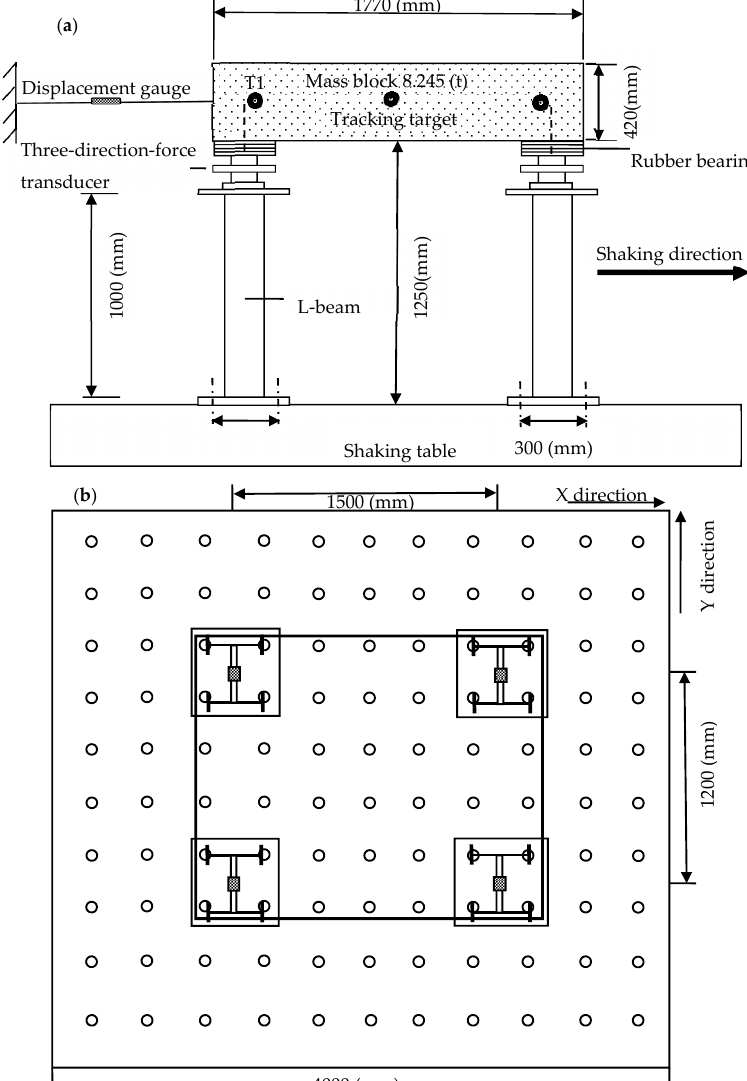
Figure 1. Layout of laminated rubber bearings on the shaking table. ( a ) Elevation view, and ( b ) planar graph view.